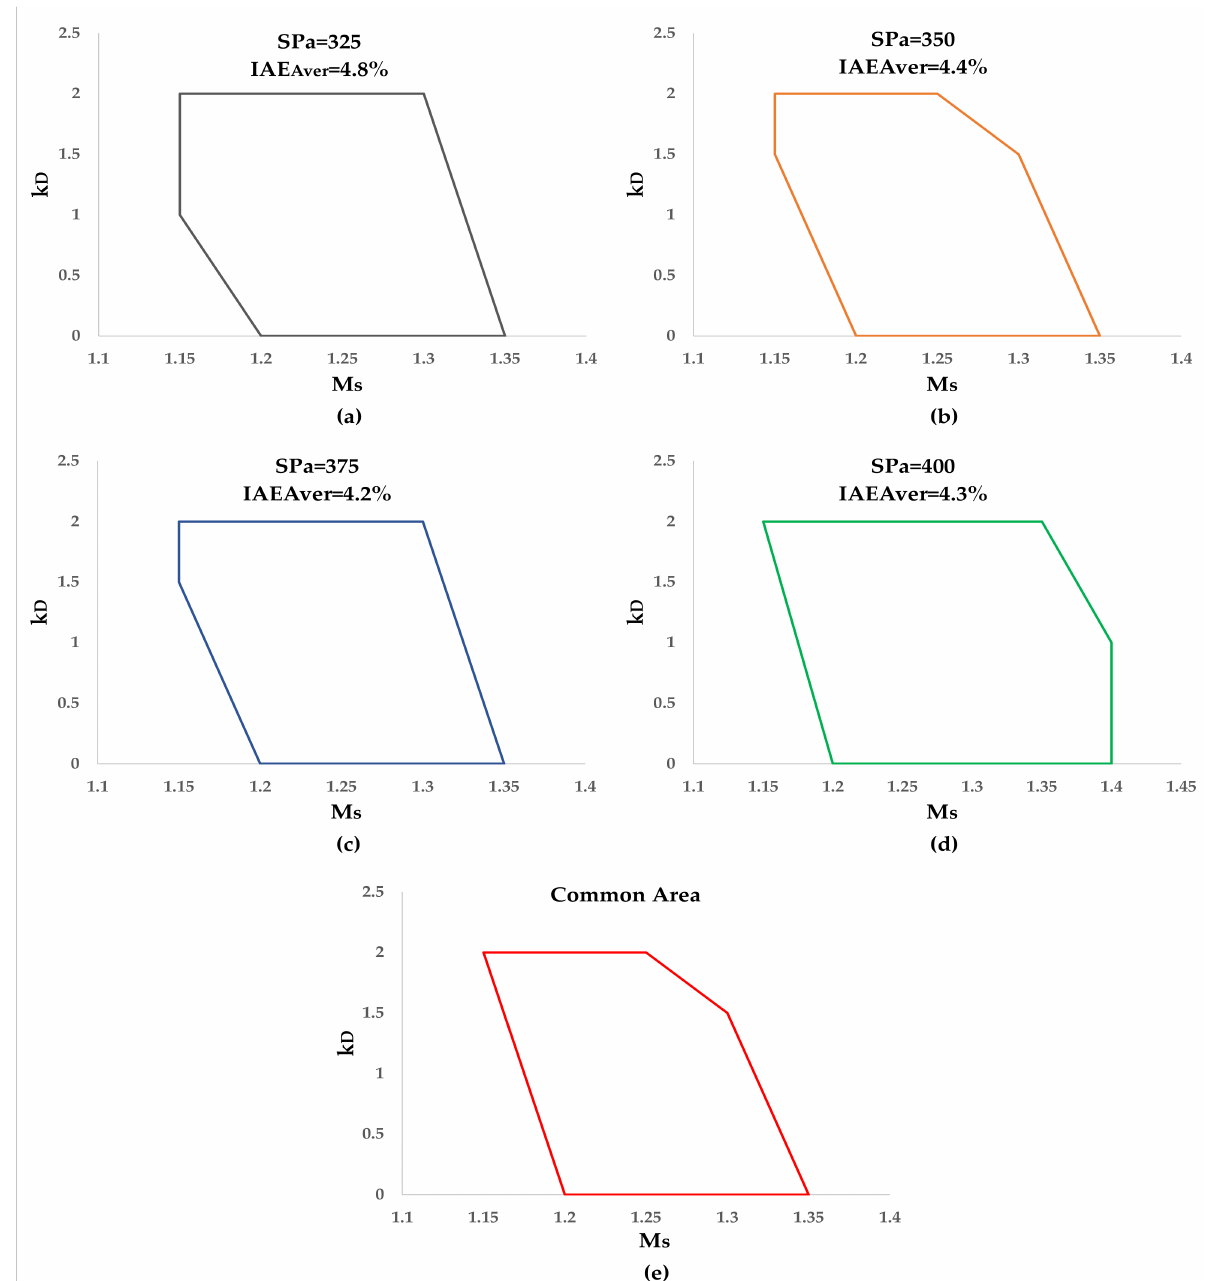
Figure 10. Optimal PID controllers for SP a : ( a ) 325 mm H 2 O; ( b ) 350 mm H 2 O; ( c ) 375 mm H 2 O; ( d ) 400 mm H 2 O; and ( e ) common area of all SP a